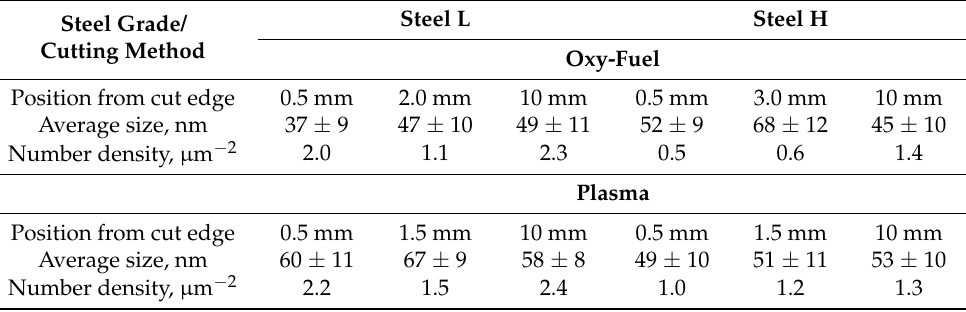
Table 5. Average parameters of fine Fe 3 C particles studied with SEM (at 10 mm away from the cut edge no heat effect was observed, therefore the microstructure at this position was considered as the